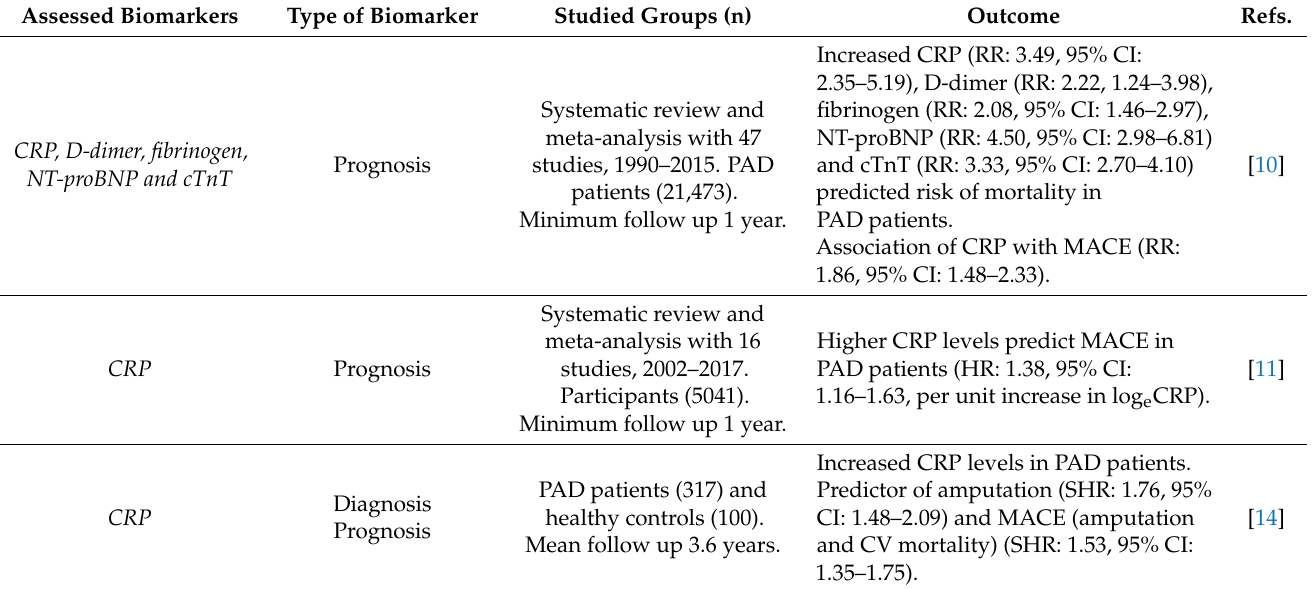
Table 1. Inflammatory biomarkers in lower limb PAD diagnosis and